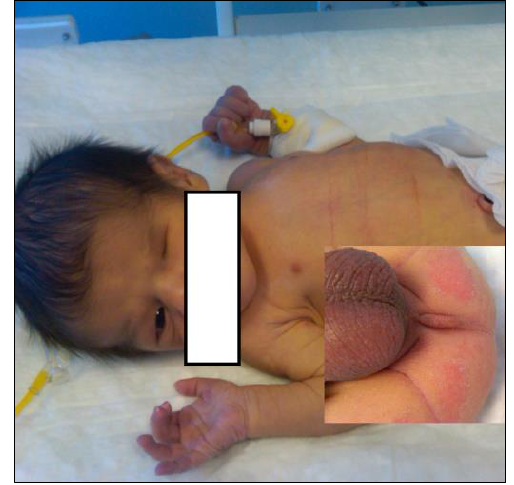
Figure 1: Anophthalmia of the patient. Inset shows imperforate